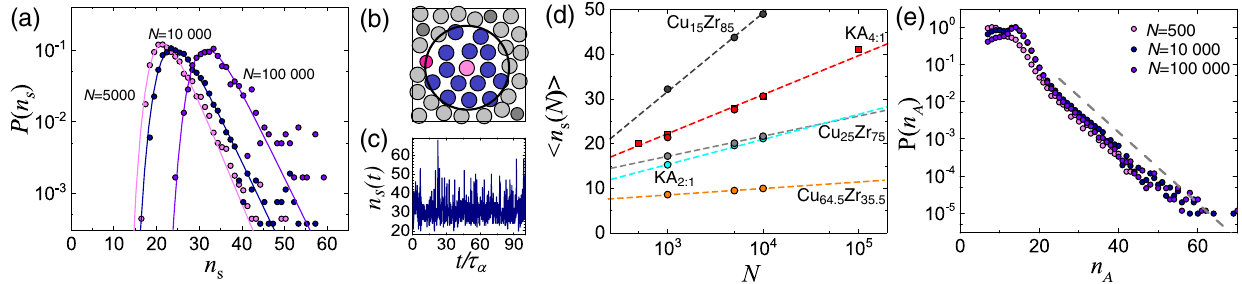
FIG. 4. Compositional fluctuations in KA and CuZr at various compositions. (a) Distributions of largest compositional fluctuations of A particles n N in KA for T ¼ 0 . 4 . Each system size is fitted with a Gumbel distribution (see text). s for several system sizes (b) Schematic indicating the order parameter n s for compositional fluctuations. Central pink particle is the A particle under consideration and dark pink particle the nearest B particle. Blue particles are A particles lying within the sphere as shown. The compositional fluctuation shown has 15 A particles. (c) Time evolution of largest compositional fluctuations n s in the liquid for the KA model with N ¼ 10 000 and T ¼ 0 . 4 . (d) Scaling of the median h n s i calculated from fitted Gumbel distributions with system size; lines are fits (see text). Shown are data for the KA mixture at various compositions along with Cu x Z r 1 − x metallic glass formers (see the Appendix for details). Circles are constant pressure data ( P ¼ 0 ) and squares are constant density data ( ρ ¼ 1 . 204 ). For the KA mixtures, constant pressure data are taken in the NVT ensemble fixing the mean pressure at h P i ¼ 0 and T ¼ 0 . 80 and constant density data are taken at T ¼ 0 . 40 . Cu NPT ensemble at T ¼ 1270 K or T ¼ 1500 K and P ¼ 0 . (e) Distribution for all compositional x Zr 1 − x is simulated in the fluctuations for several system sizes ( 4 ∶ 1 KA mixture) at T ¼ 0 . 40 . The distribution is independent of system size above n A > 25 . Dashed line denotes exponential decay with decay constant λ ¼ 0 . 22 (see